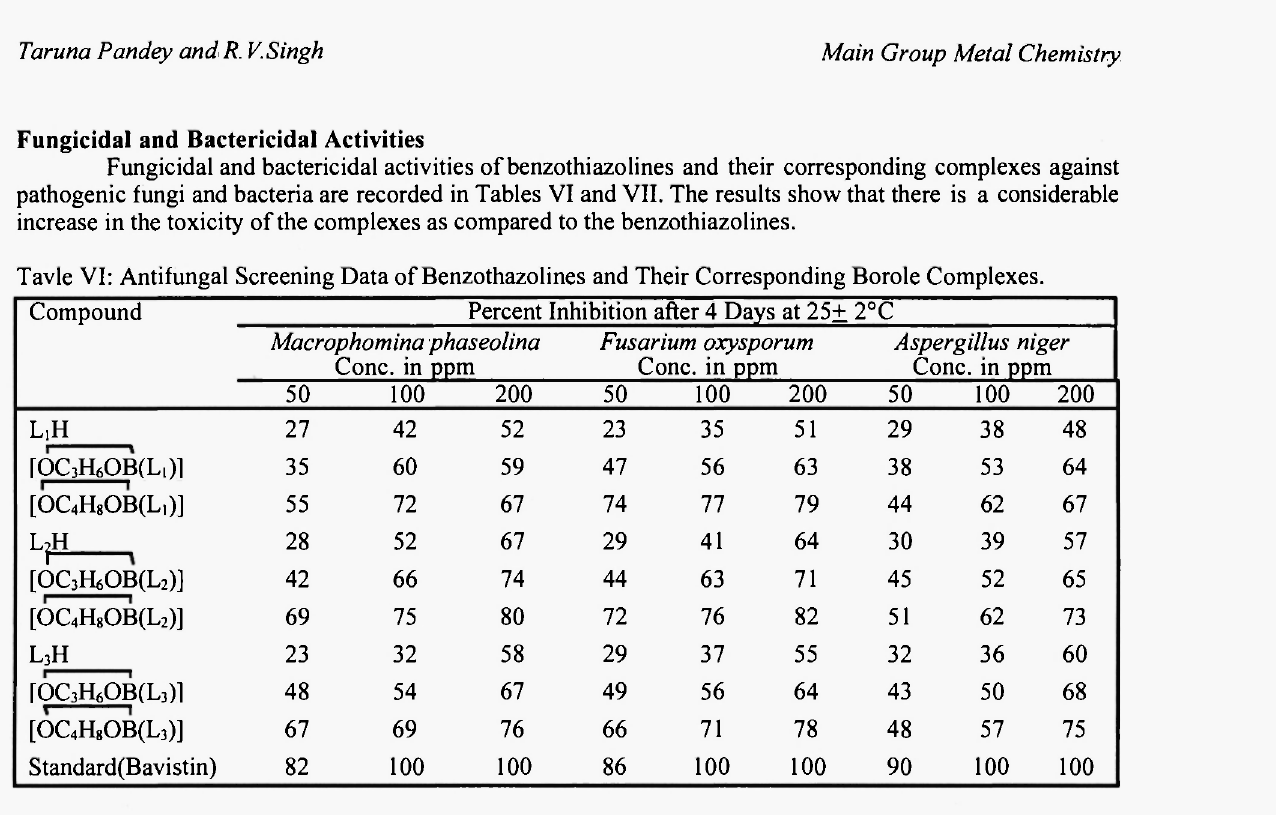
Table VII: Antibacterial Screening Data of Benzothiazoline and Their Borole